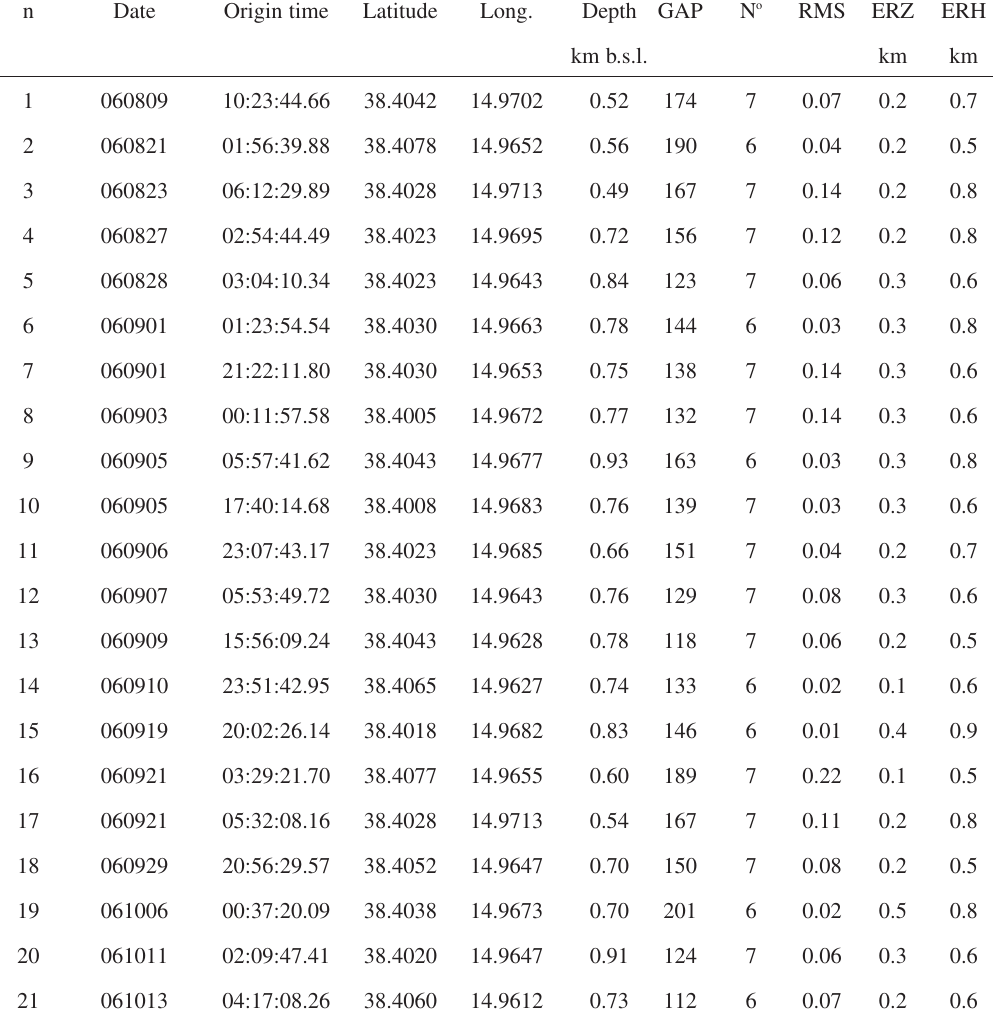
Table I. Hypoellipse location parameters of the analyzed earthquakes. n Origin time Latitude